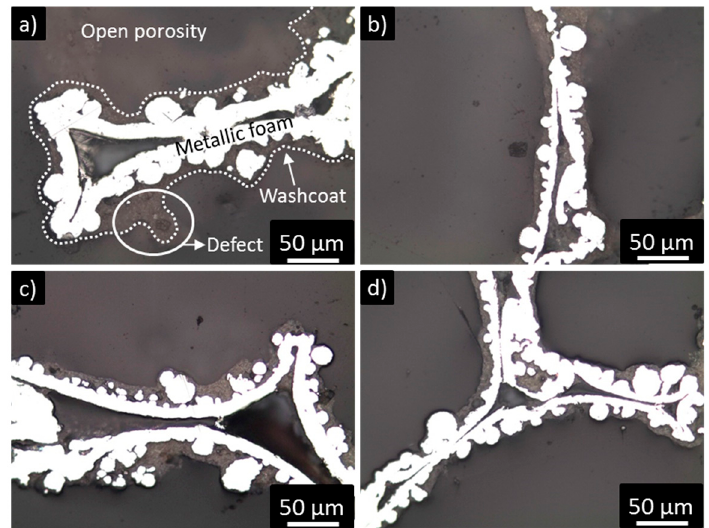
Figure 6. Optical microscope analysis of deposited catalytic layers: S1200 ( a , c ) and S580 ( b , d ) samples. Deposition were made by dip coating ( a , b ) and spin coating ( c , d ).